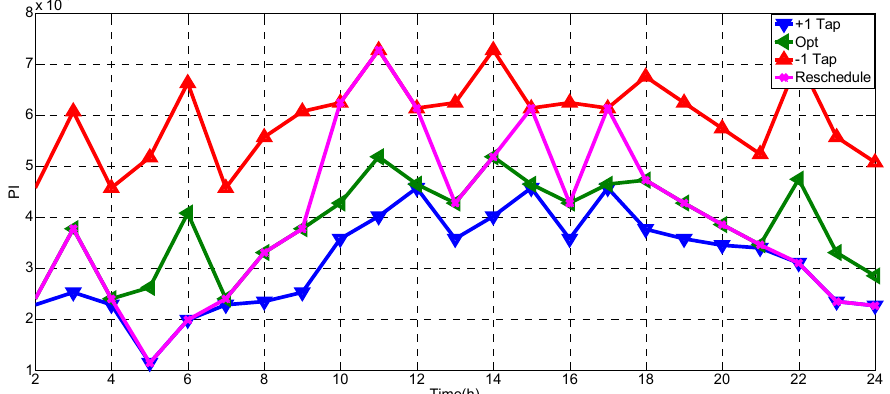
Figure 16. Performance index (PI) of each tap position schedule.